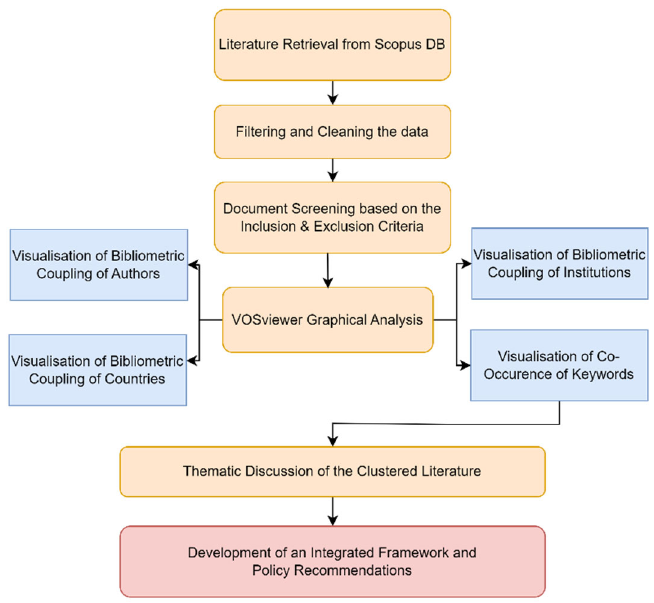
Figure 2. Flow chart of the systematic ‐ cum ‐ bibliometric review process.